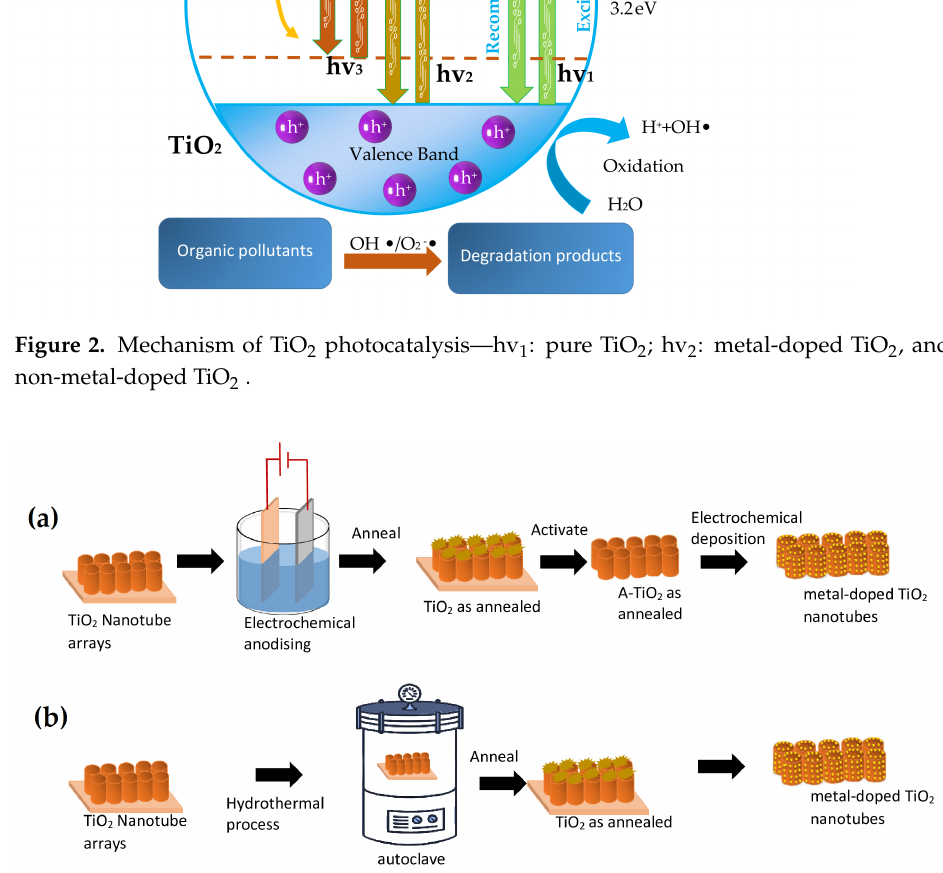
Figure 3. Schematic representation of the most used methods to dope TiO 2 nanotubes using metals: ( a ) Self-assembled electrochemical anodizing method ( b ) Hydrothermal